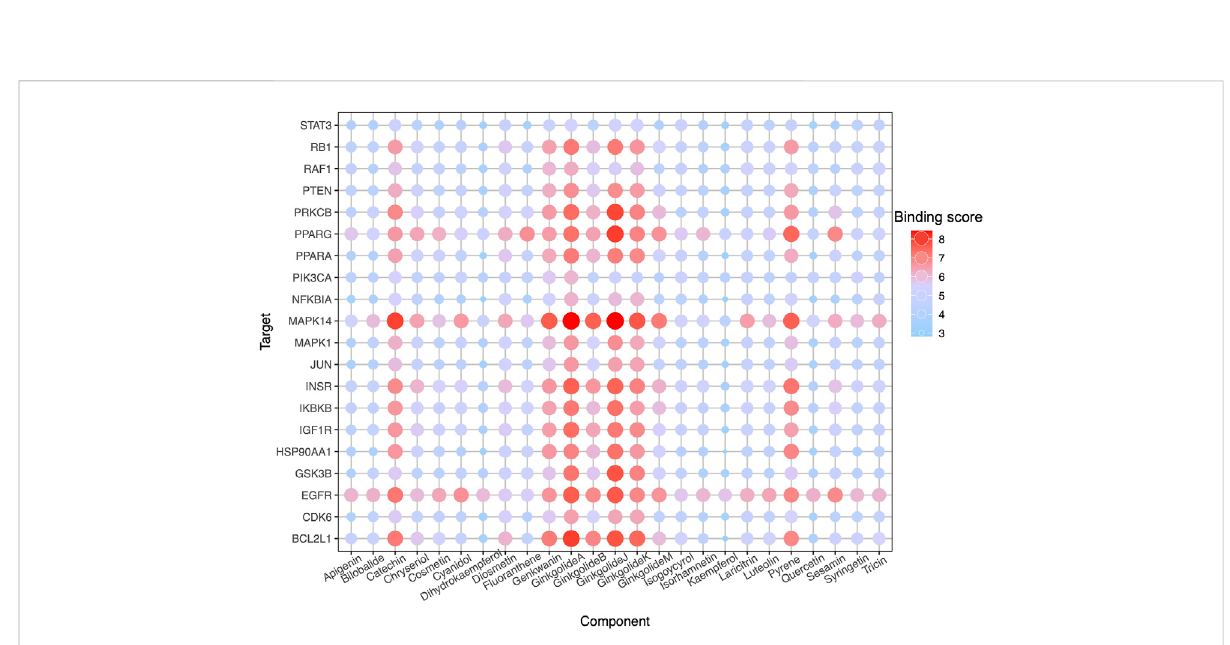
FIGURE 6 DTIprediction. Dot-matrixshowed abinding score predicted using thecnn_cnn_bindingdb model, apre-trained deep modeofDeepPurpose. The color and size of dots indicate the level of binding